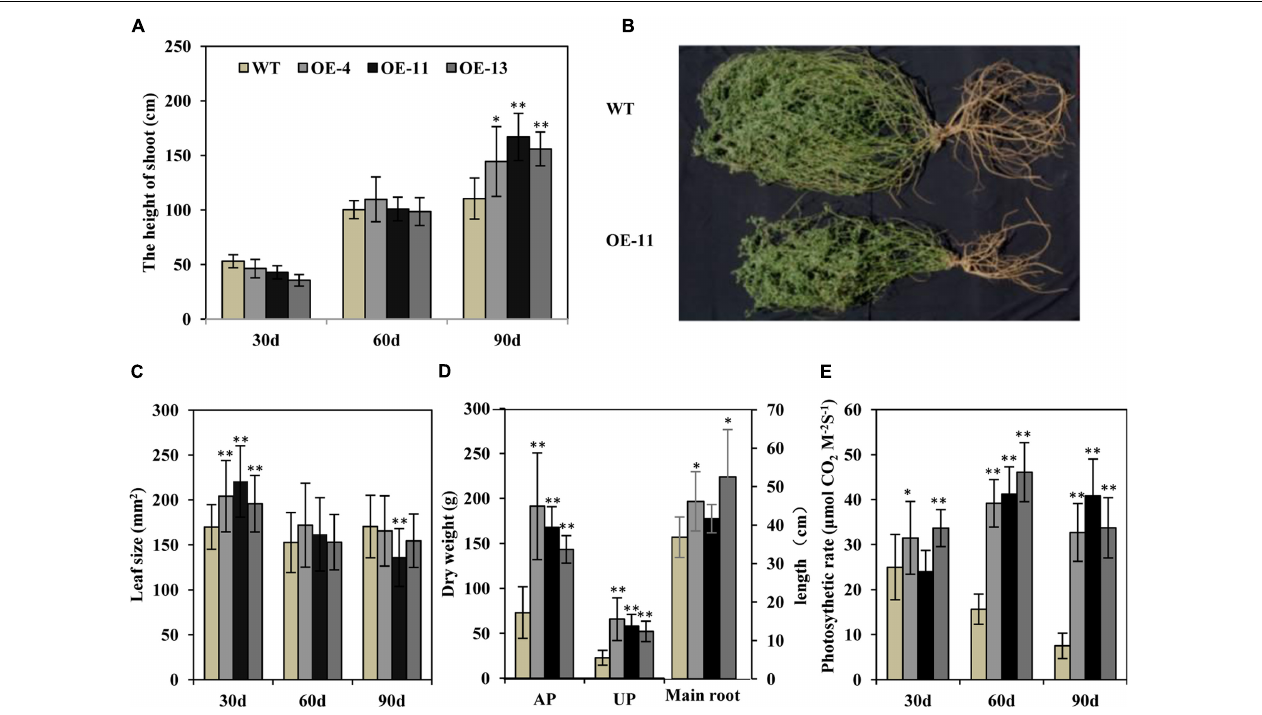
FIGURE 8 | Effects of drought stress on wild type and transgenic alfalfa plants in a field trial. (A) Shoot height of wild type and transgenic plants at 30-, 60-, and 90-day in field trial. (B) Phenotype of wild type (upper panel) and transgenic (lower panel) plants after 90-day in field trial. (C) Leaf size of wild type and transgenic plants at 30-, 60-, and 90-day field test. (D) Left: dry weight of above-ground part (AP) and underground part (UP) in wild type and transgenic alfalfa plants. Right: length of main roots in wild type and transgenic alfalfa plants. (E) Photosynthetic rate of wild type and transgenic plants at 30-, 60-, and 90-day field trial. Values are means ± SD of three replicates ( ∗ P < 0.05, ∗∗ P <